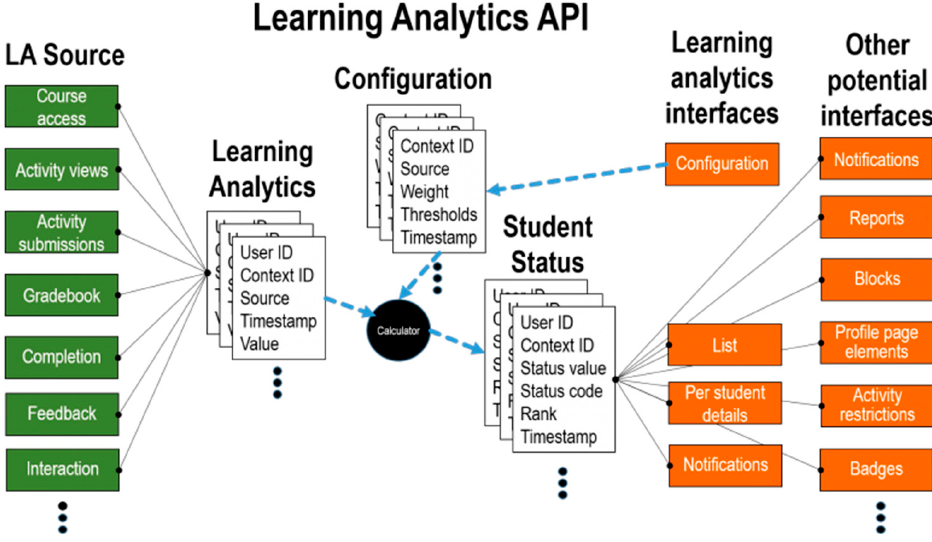
Figure 3. Moodle—Learning Analytics data gathering API